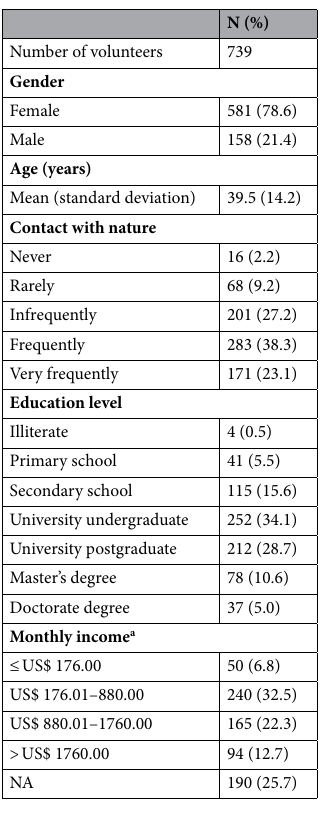
Table 1. Participant characteristics (n = 739). a Approximate conversion from Brazilian Real to American Dollar on May 20,